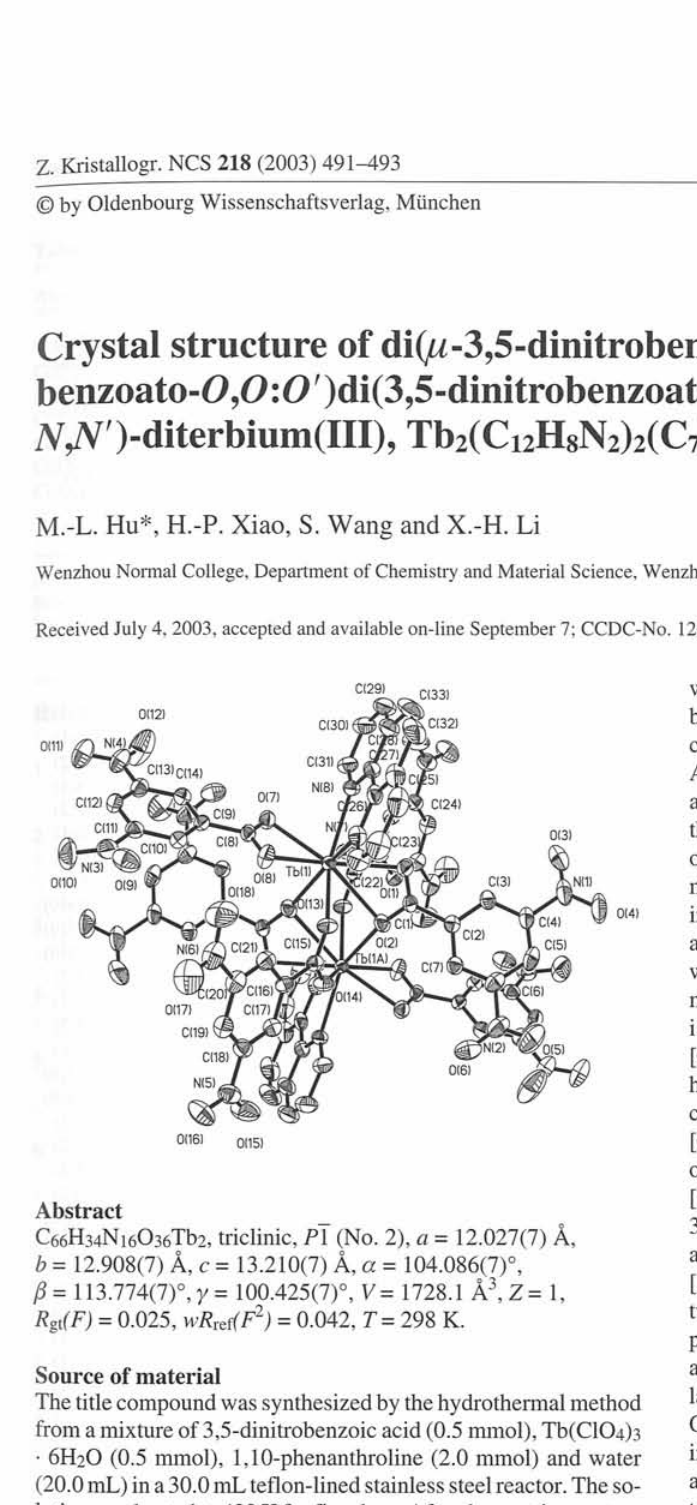
Table 1. Data collection and handling.